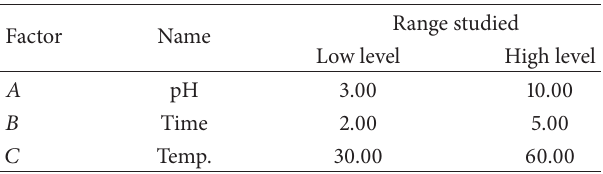
Table 1: Ranges of various independent process variables (temper- ature, pH, and process time) used in RSM.